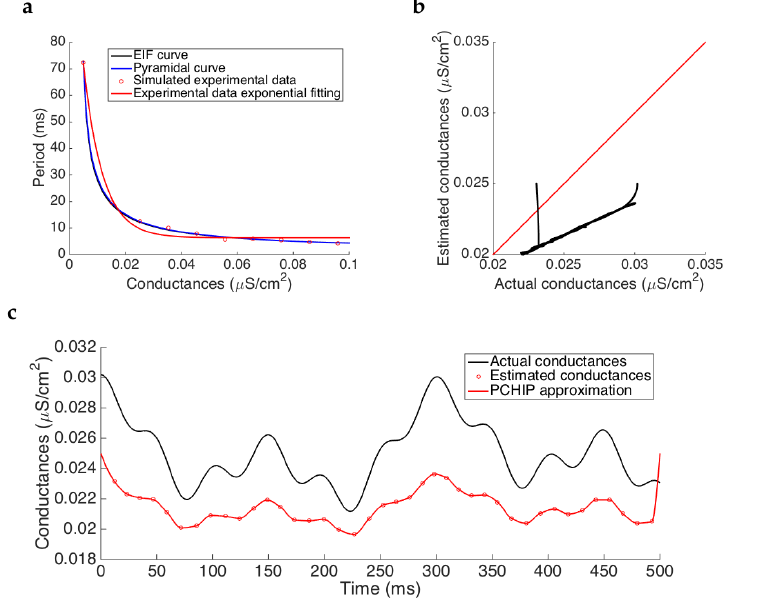
Figure 7. Results of the estimation procedure applied to a membrane potential generated through the pyramidal cell model with additive noise and using a simulated T − g syn curve in the estimation procedure. Panel ( a ) shows the actual T − g syn curve (blue curve), the T − g syn curve obtained with the EIF method (black curve), a simulation of an experimental T − g syn curve (red dots), and an exponential fitting of the experimental curve (red curve). Panel ( b ) shows the scatter plot of the prescribed conductances versus the estimated ones; the red line represents the identity line. Panel ( c ) shows the prescribed conductances (black curve) and the estimated conductances (red curve). In panel ( a ), the experimental curve (red dots) has been computed using 10 different trials where noise has been added to the period (a random normal distributed value with 0 mean and 0.5 standard deviation and dots has been interpolated using the exponential